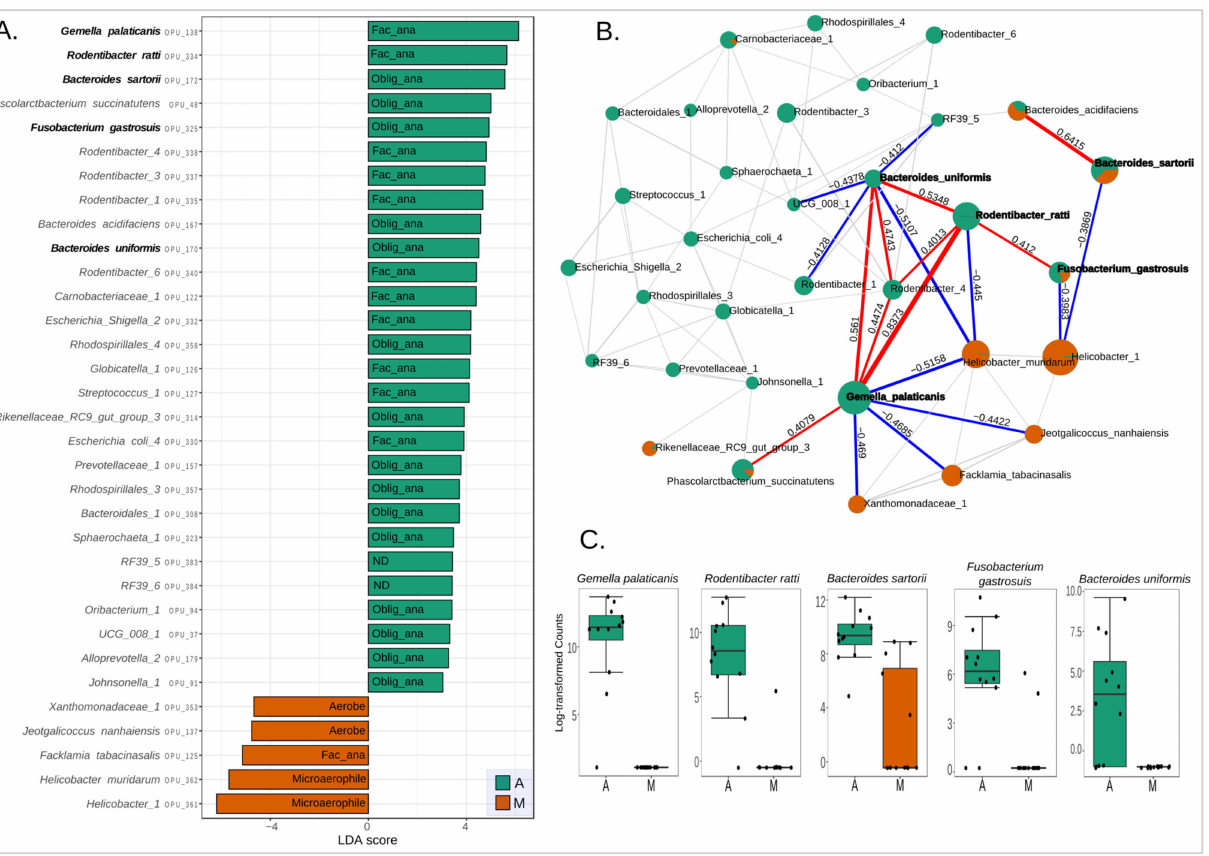
Figure 5. Anastomosis group and control group species abundance and correlation network anal- ysis. ( A ) LEfSe-LDA score >2 identified species that differ significantly in abundance between groups (raw p -value cutoff < 0.05, Kruskal–Wallis test). Species with a Kruskal–Wallis FDR-adjusted p -value < 0.05 were highlighted. ( B ) Correlation networks (SparCC) of 33 species depicted in LEfSe-LDA. Correlation threshold > 0.3 and p -value threshold < 0.05 were used. The nodes (pie charts) represent species, size reflects relative abundance, with the anastomosis group in green and the control group in orange. Correlation values of species with an FDR-adjusted p -value < 0.05 in LDA-LEfSe were labeled, along with their connections. Positive and negative correlations in red and blue lines, respectively. The thickness of the line represents the strength of the correlation. ( C ) Boxplot of the abundances of species with an FDR-adjusted p -value < 0.05 in LDA-LEfSe. Fac_ana: facultative anaerobe,